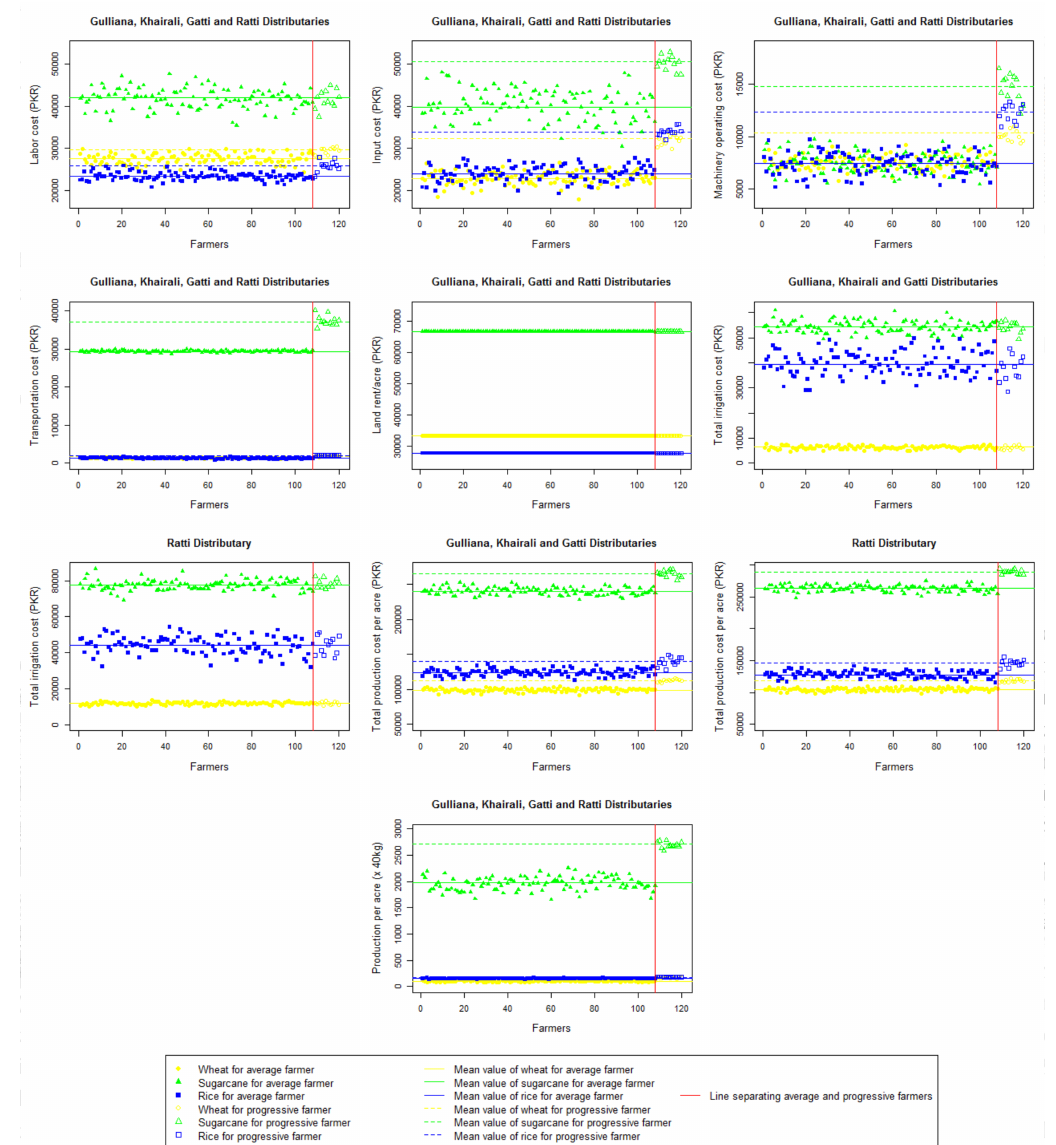
Figure 4. Cost of production for crops against yields in CCA of